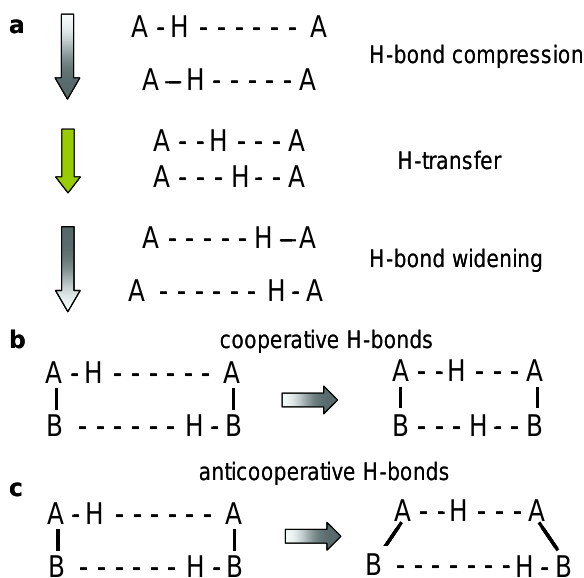
Figure 1. ( a ) Hydrogen bond compression during hydrogen transfer [2–16]. ( b ) Cooperativity and ( c ) anti-cooperativity of two coupled hydrogen bonds [5–12]. Cooperativity leads to a concerted double proton transfer, anti-cooperativity to a stepwise double proton transfer.